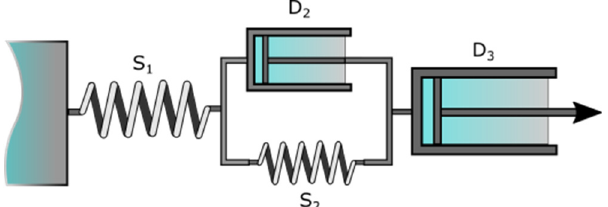
Figure 1. Burguer model comprising the Maxwell and Kelvin-Voigt models in series. S 1 and D 3 correspond to the Maxwell spring and dashpot, respectively, while S 2 and D 2 represent their Kelvin-Voigt counterparts.